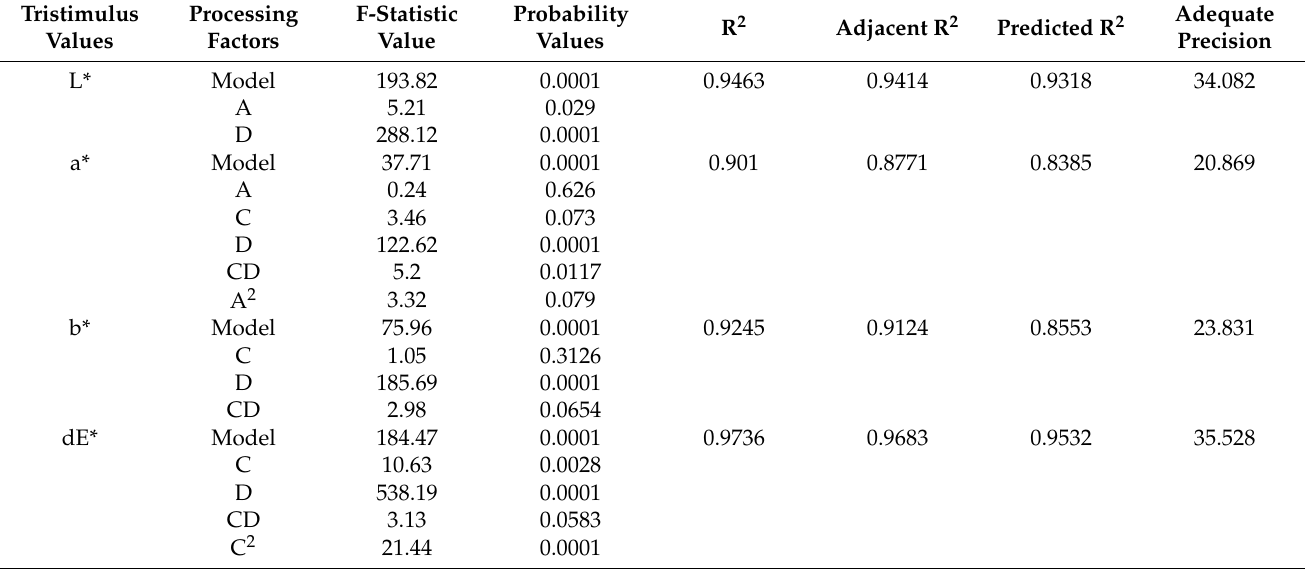
Table 4. ANOVA for the color of three grades.